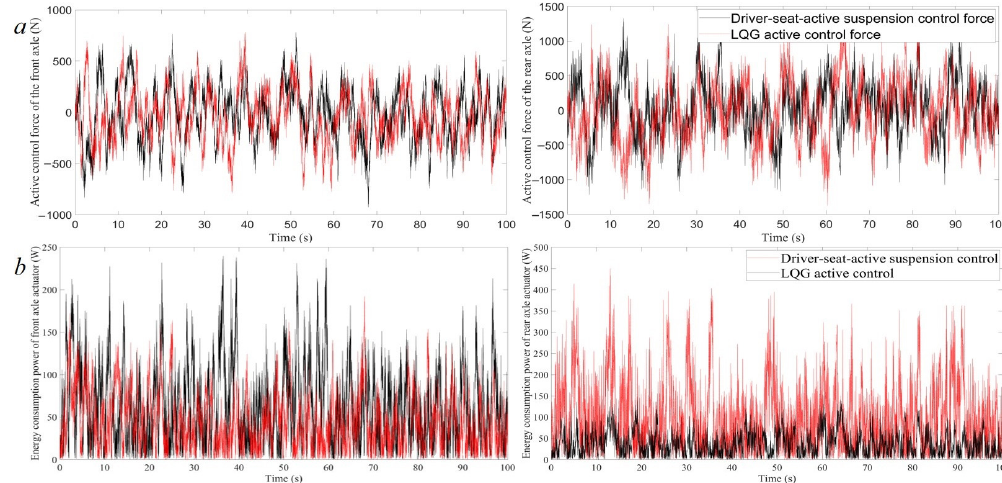
Figure 7. Comparison of actuator performance. ( a ) Active control force of the actuator. ( b ) Energy consumption power of the actuator.